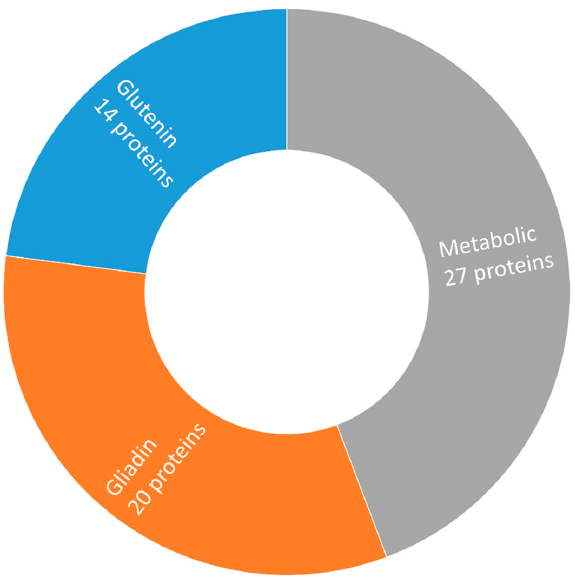
Figure 3. The proportion of grain protein groups differentially accumulated among investigated Triticum aestivum L. cultivars revealed the most diverse non-gluten fraction. Information about the functional role of proteins was extracted primarily from UniProt.